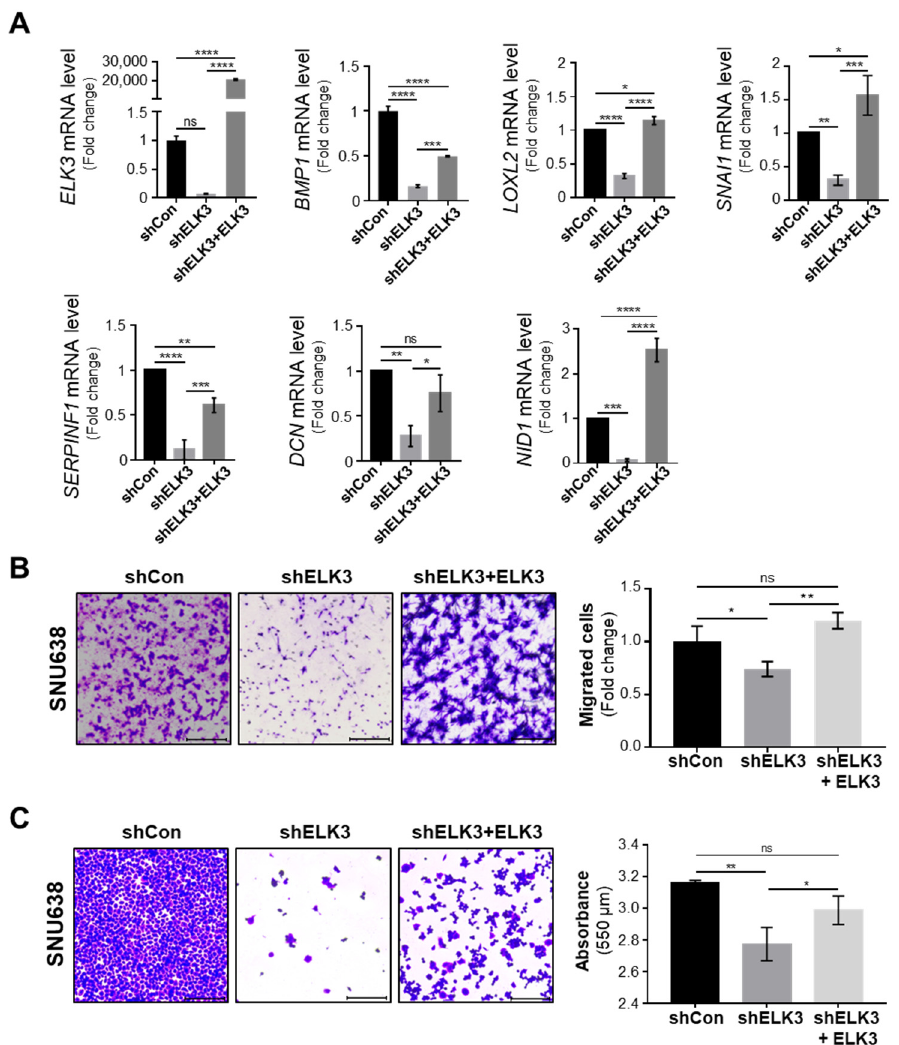
Figure 5. ELK3 is required for gastric cancer cell migration and adhesion. ( A ) Expression of mRNA encoding the indicated genes in SNU638 cells transfected with shCon, sh ELK3 , or sh ELK3 plus pLenti-cMyc-DDK- ELK3 plasmid DNA. Error bars represent the standard deviation; * p < 0.05, ** p < 0.01, *** p < 0.001, and **** p < 0.0001 (one-way ANOVA). ( B ) Representative images showing the cell migration of SNU638 cells transfected with shCon, sh ELK3 , or sh ELK3 plus pLenti-cMyc-DDK- ELK3 plasmid DNA. Scale bar, 200 μ m. Bar graphs indicate the number of migrated cells. Error bars represent the standard deviation; * p < 0.05 and ** p < 0.01 (one-way ANOVA). ( C ) Representative images showing cell adhesion of SNU638 cells transfected with shCon, sh ELK3 , or sh ELK3 plus pLenti-cMyc-DDK- ELK3 plasmid DNA. Scale bar, 200 μ m. Bar graphs indicate the absorbance value of adherent cells. Error bars represent the standard deviation; * p < 0.05 and ** p < 0.01 (one-way ANOVA). ELK3, ETS transcription factor ELK3; sh, short hairpin RNA; Con, control.